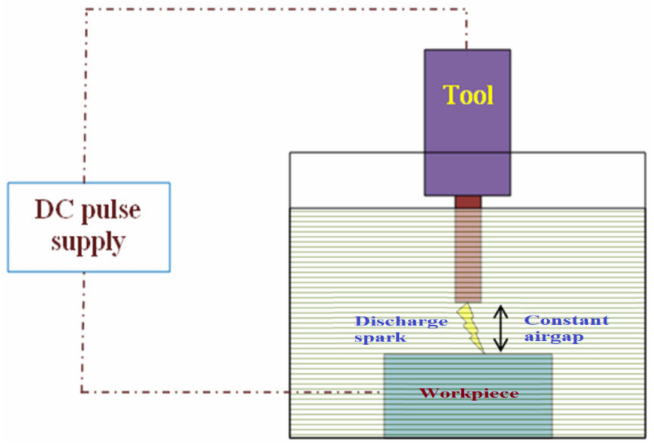
Figure 1. Schematic representation of the EDM